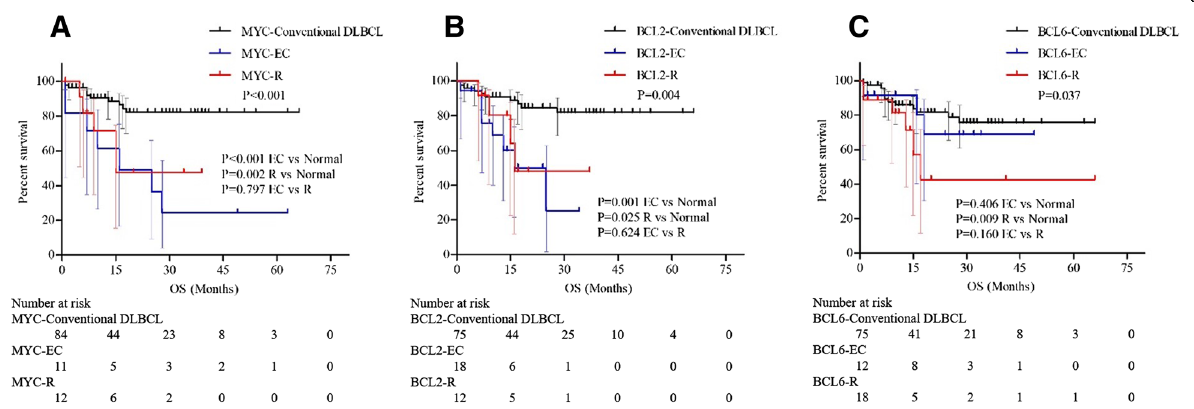
Fig. 2 Overall survival comparison between patients with MYC, BCL2 or BCL6 extra copies (EC) and rearrangements (R). ( a ) patients with MYC EC vs patients with MYC R; ( b ) patients with BCL2 EC vs patients with BCL2 R; ( c ) patients with BCL6 EC vs patients with BCL6